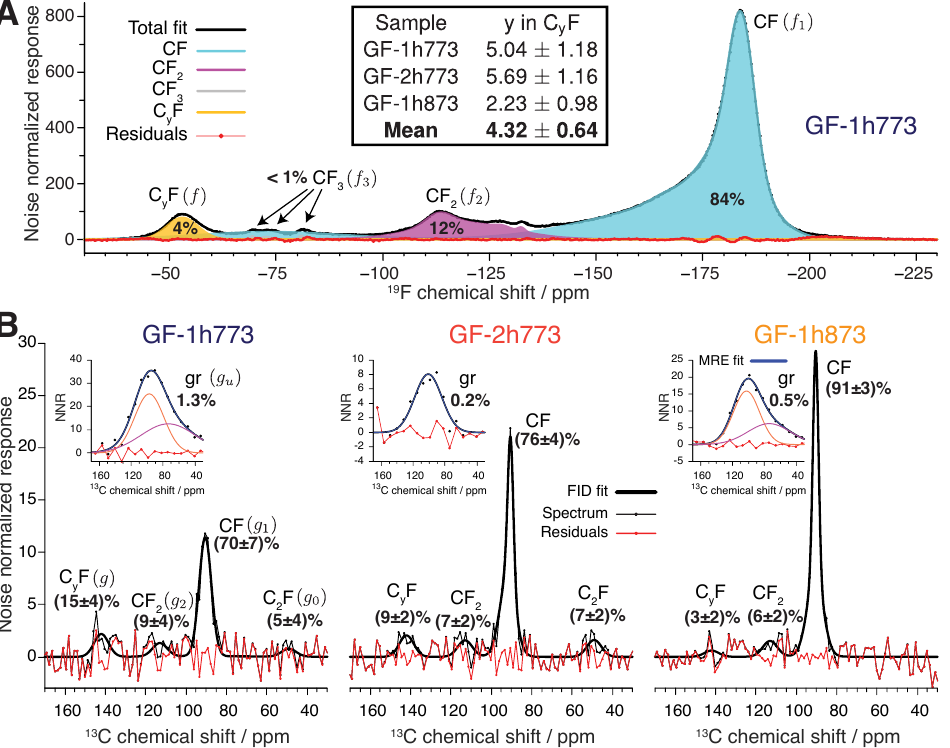
quantitative 19 F NMR ( f fractions) and Table 2 for quantitative 13 C NMR ( g fractions).